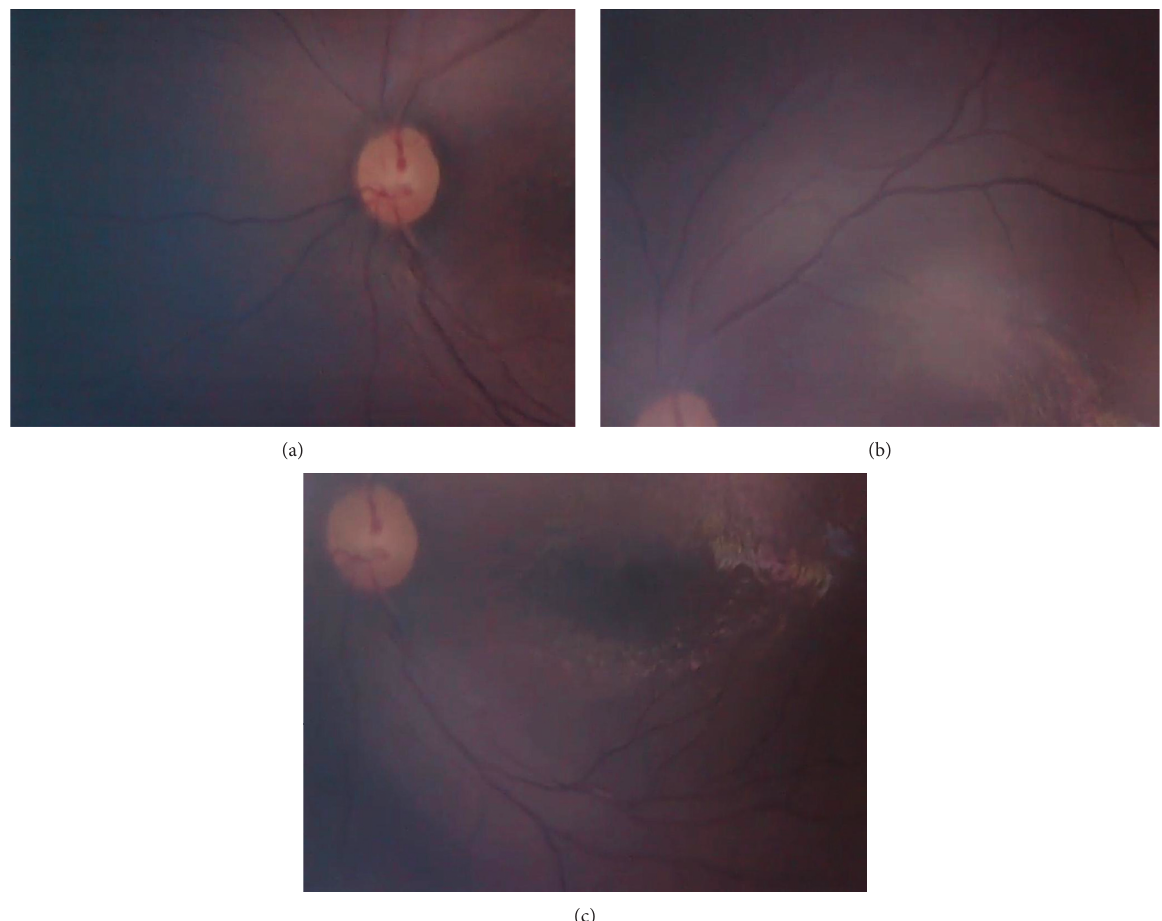
Figure 5: (a–c) Pictures of nasal and temporal superior and inferior retina, zones 1 and 2.